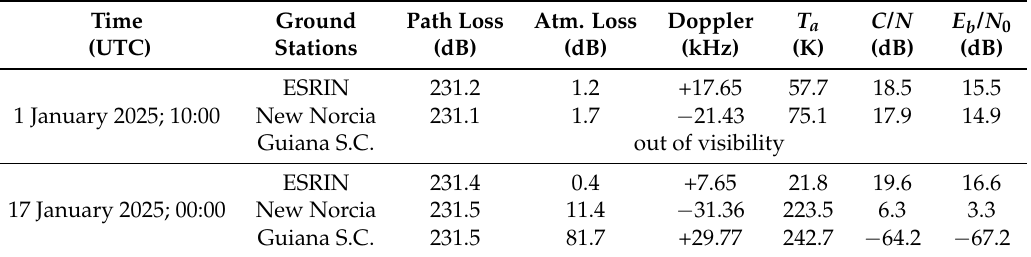
Table 3. Results of the Mission Scenario Simulations carried out with Systems Tool Kit (STK). Time